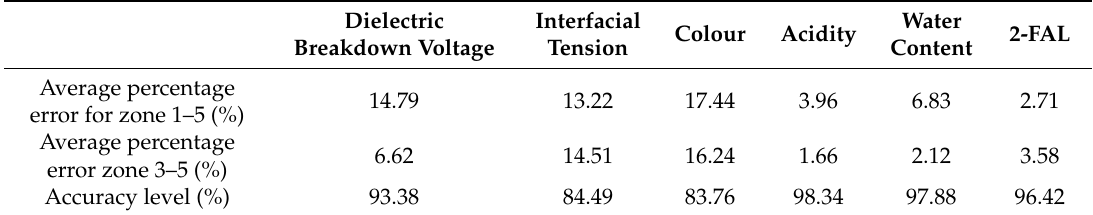
Table 7. Average percentage error and accuracy level for oil